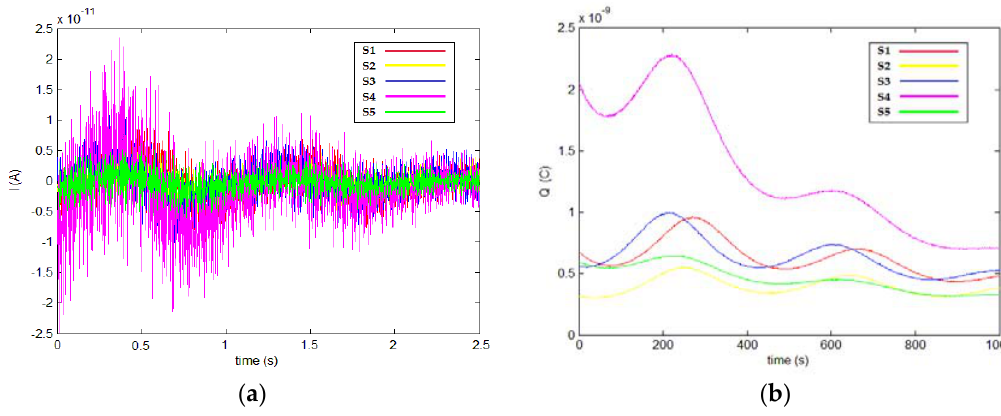
Figure 9. ( a ) Induced current curve and ( b ) induced charge curve after processing.